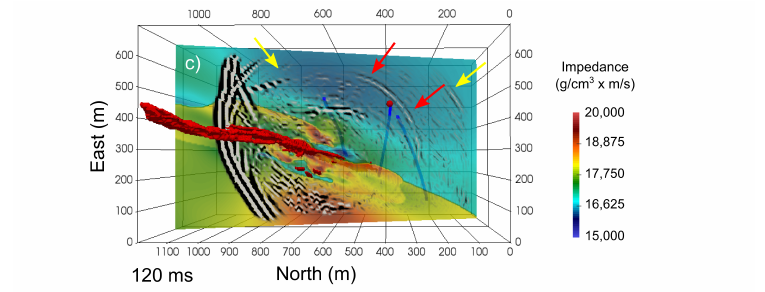
Figure 7. Wavefield snapshots over acoustic impedance model at time steps of 40 ms ( a ), 80 ms ( b ) and 120 ms ( c ). The semi-massive to massive sulfide mineralization is depicted as a 3D red surface. Virtual receivers for boreholes KU-917, KU-936B and KU-941 are shown as blue solid lines. The source position for shot SP10 is shown as a red sphere. Yellow arrows in (b,c) highlight the reflection from the KAL-OME contrast, whereas red arrows denote a reflection arising from the S/MS deposit. The synthetic shot records are shown in Figure 8.